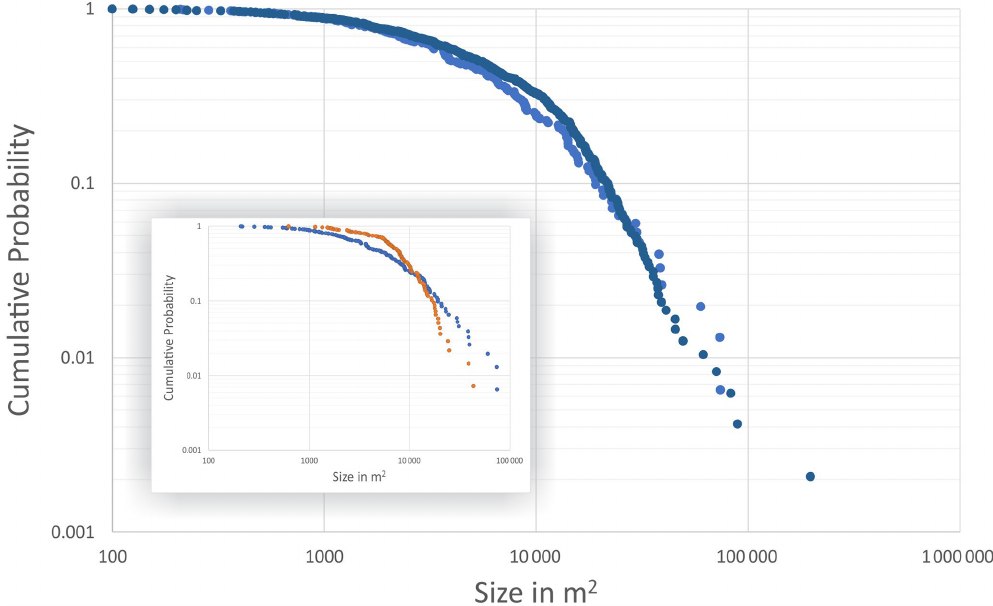
Figure 4. Example of a magnitude–frequency graph of modeled and mapped landslides from a well-calibrated model run and an earlier poorly calibrated model run